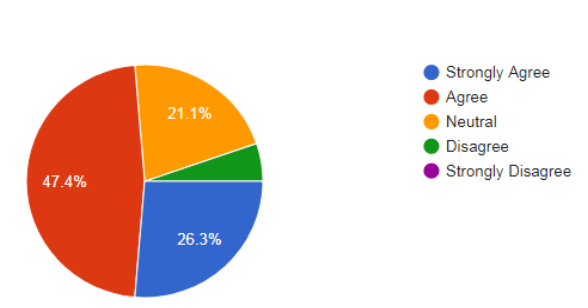
Figure 5: The materials distributed were useful